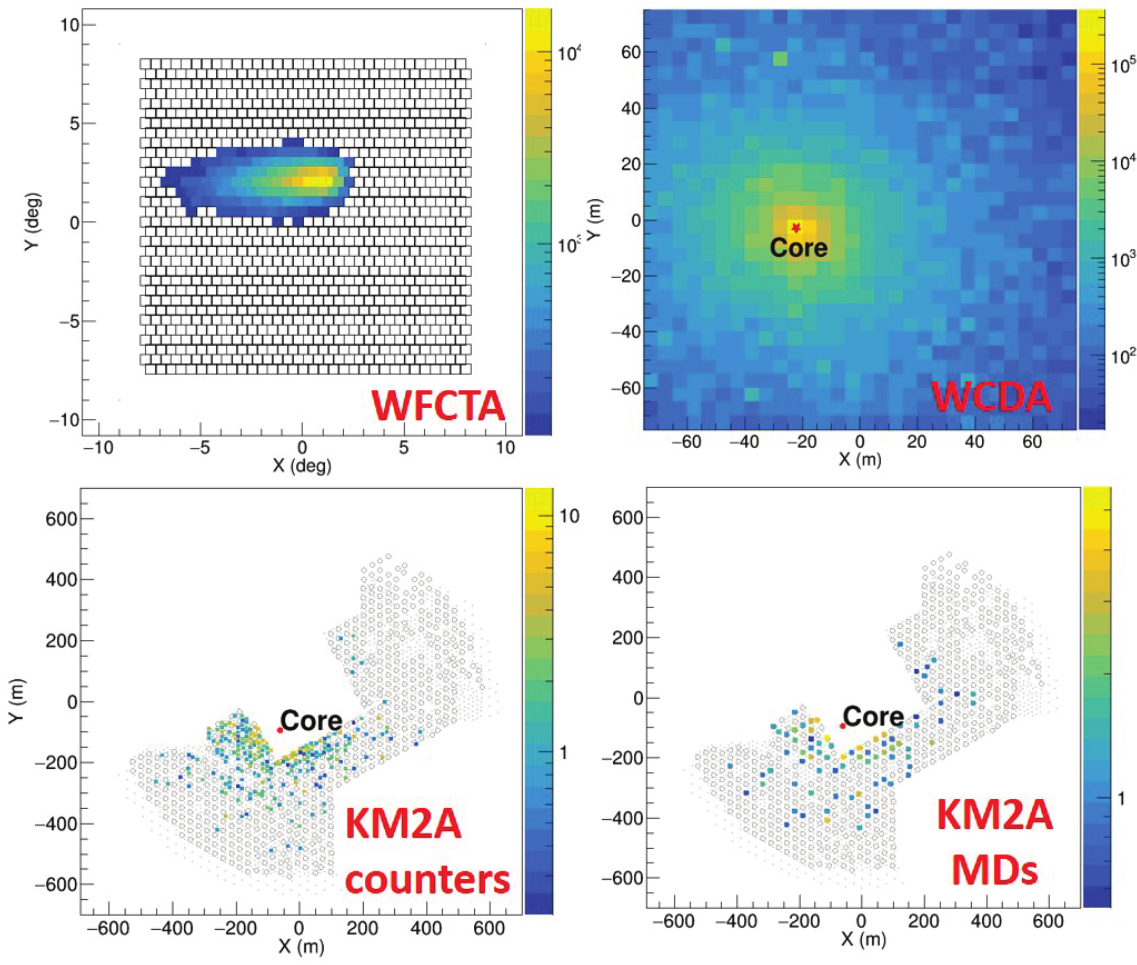
Figure 4. A typical hybrid event recorded in